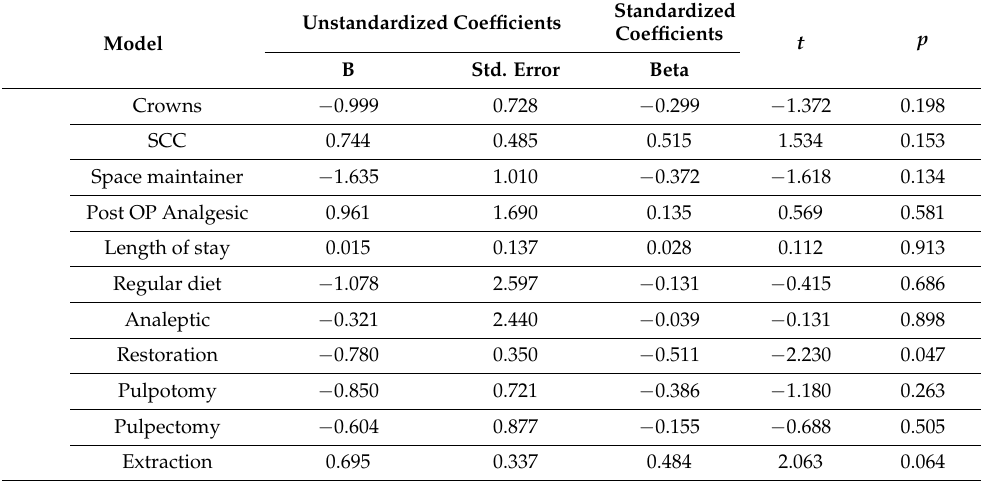
Table 7. Linear regression analysis for discomfort after dental treatment of young children under general